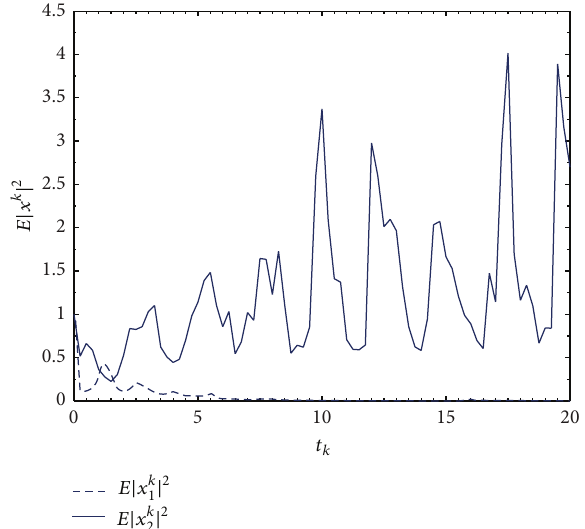
Figure3:InstabilityofSSBEnumericalsolutionsofsystem(45)with ℎ = 0.25